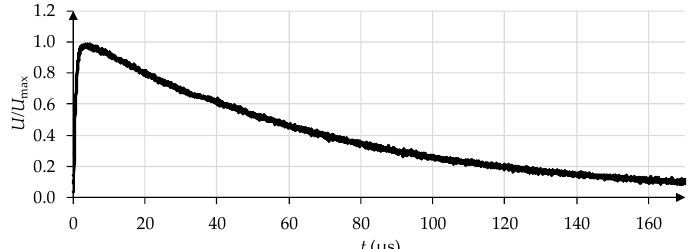
Figure 4. LI generated by the test setup ( T 1 = 1.96µs, T 2 =